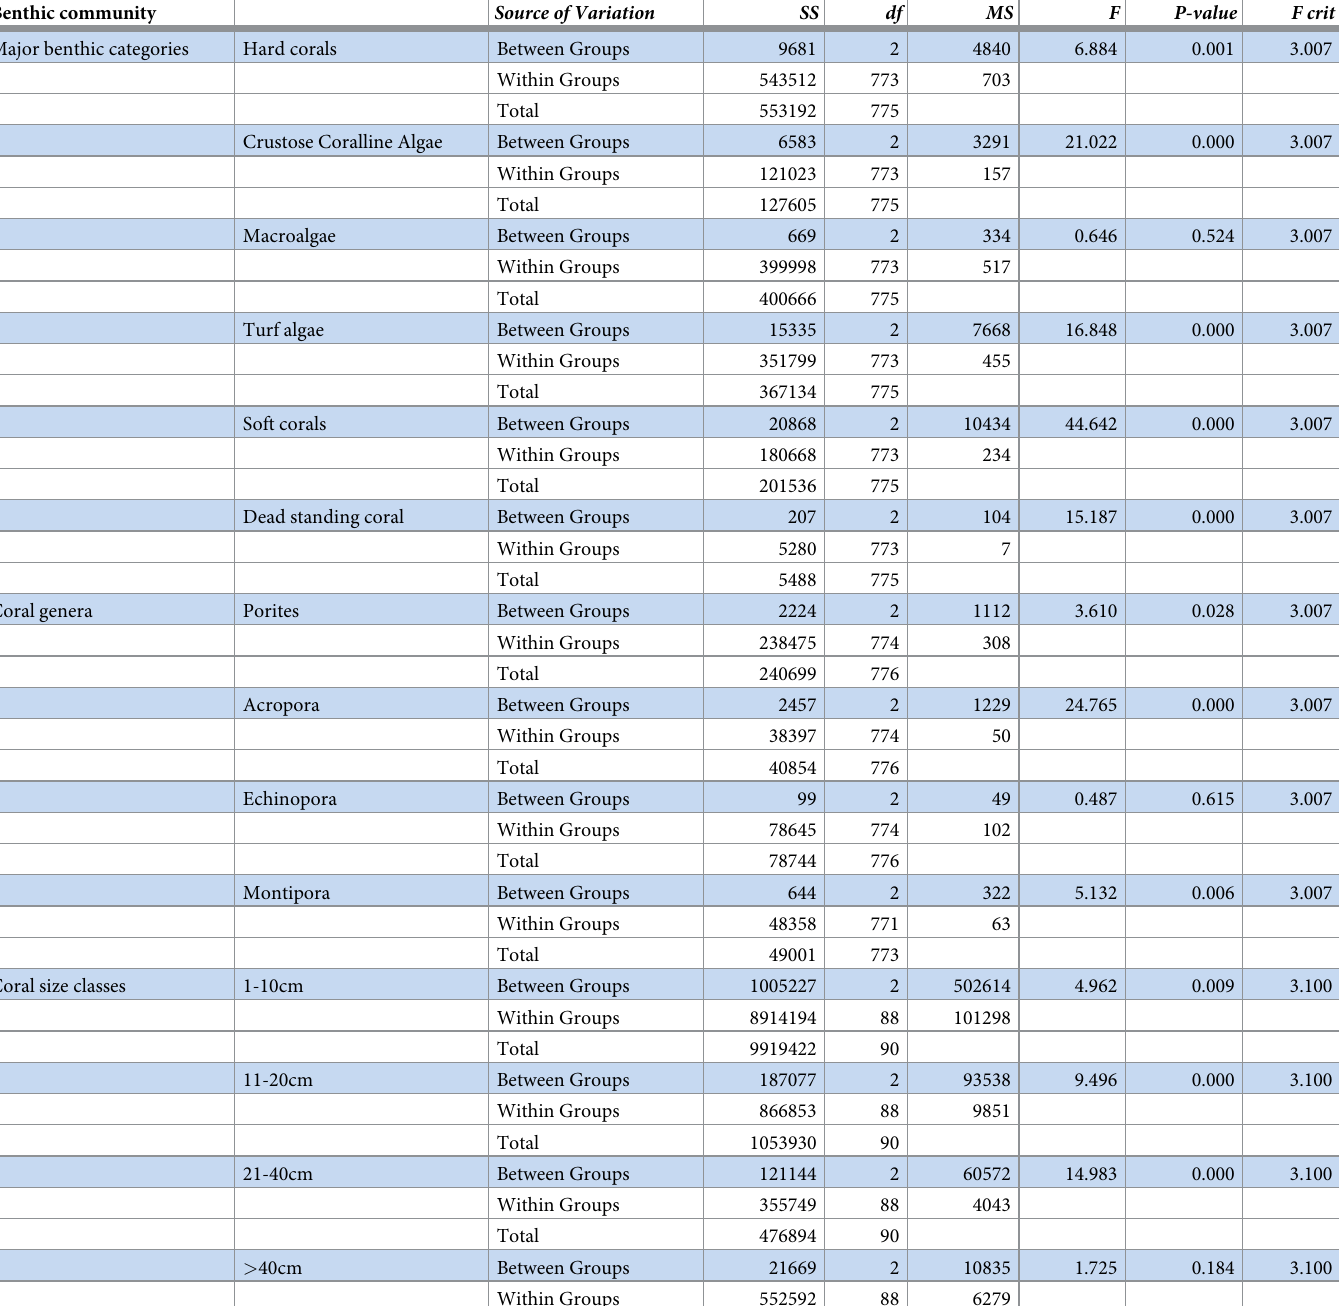
Table 2. ANOVA test on variation of benthic communities across three geographical zones. Results of One-way ANOVA test done to determine variation of key ben- thic communities across the 3 geographical